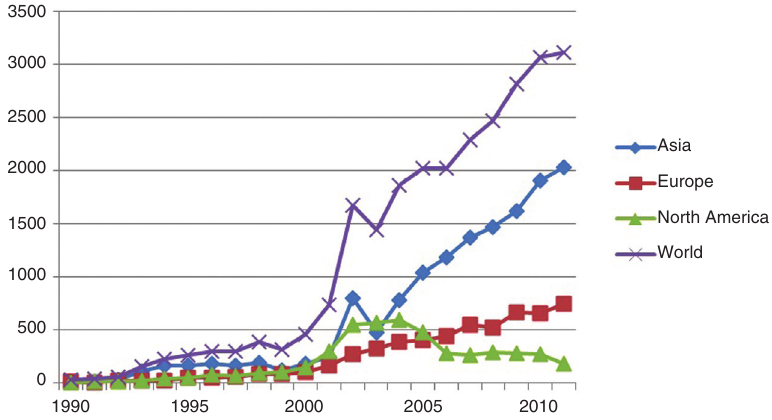
Figure 1 Number of patent publications in the area of micro-structural and